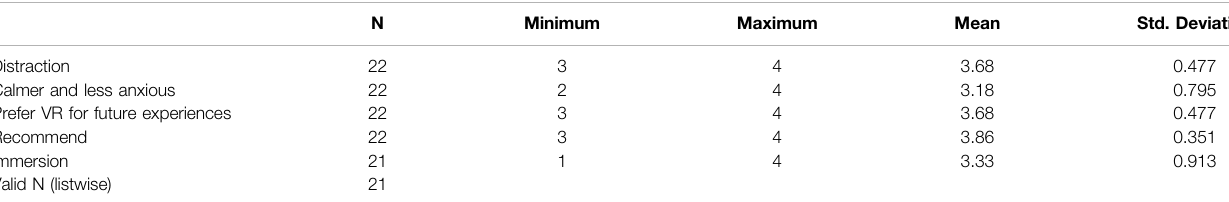
TABLE 6 | Postintervention descriptive